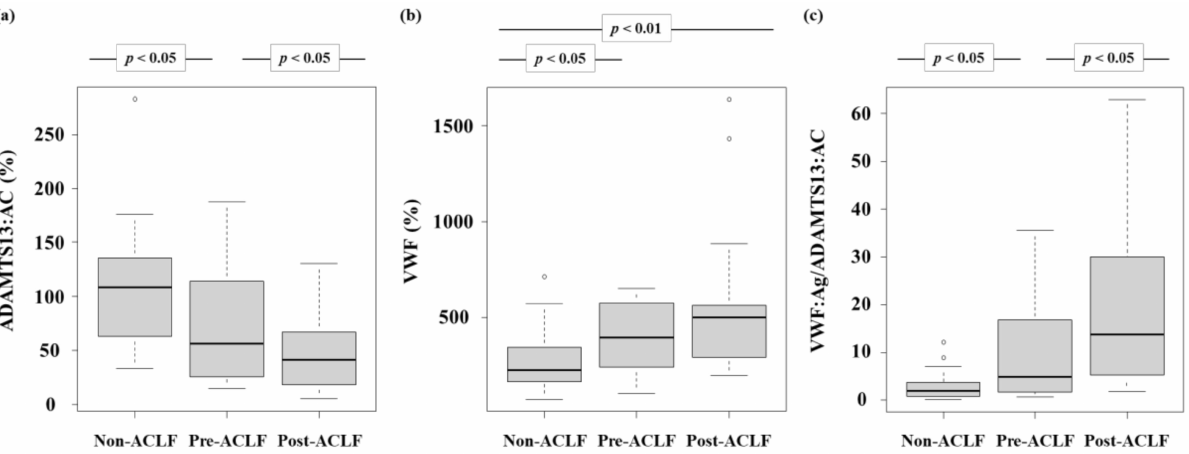
Figure 2. Plasma ADAMTS13:AC and VWF:Ag levels. ( a ) ADAMTS13:AC levels in patients with LC gradually decreased in the order of the non-ACLF group, pre-ACLF group, and post-ACLF group ( p < 0.05). ( b ) VWF:Ag levels in patients with LC gradually increased in the order of the non-ACLF group, pre-ACLF group, and post-ACLF group ( p < 0.05). ( c ) The VWF:Ag/ADAMTS13:AC levels in patients with LC gradually increased in the order of the non-ACLF group, pre-ACLF group, and post-ACLF group ( p < 0.05). ACLF, acute-on-chronic liver failure; LC, liver cirrhosis; ADAMTS13, a disintegrin-like and metalloproteinase with thrombospondin type 1 motifs 13; ADAMTS13:AC, ADAMTS13 activity; VWF, von Willebrand factor; VWF:Ag, VWF antigen; VWF:Ag/ADAMTS13:AC, the ratio of VWF:Ag to